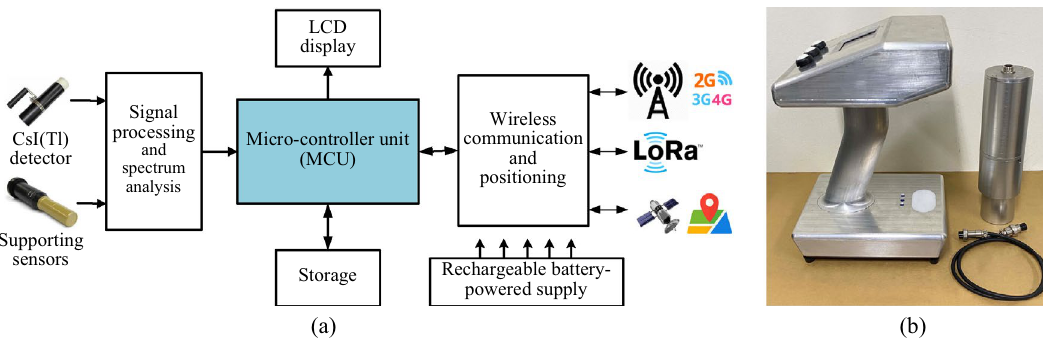
Figure 6. The mobile device: ( a ) architecture block diagrams and ( b ) an image of its